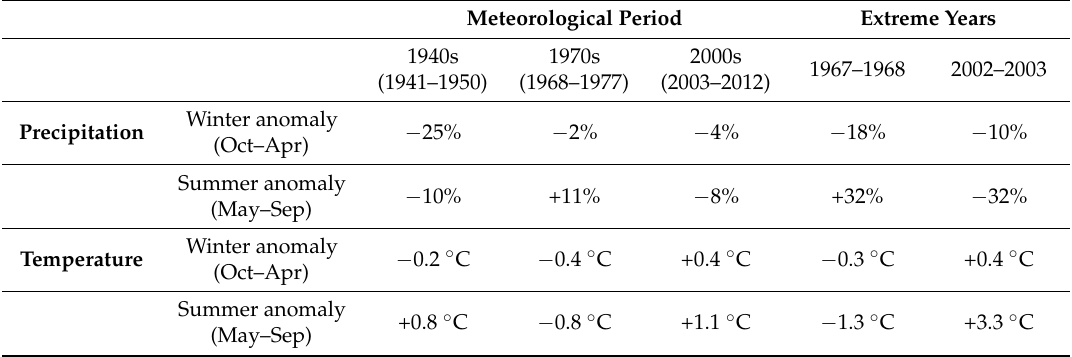
Table 2. Air temperature and precipitation anomalies for the meteorological periods and single extreme years analyzed in this study (reference period: 1961–2010).